Question: Summarize what this figure shows in one sentence.
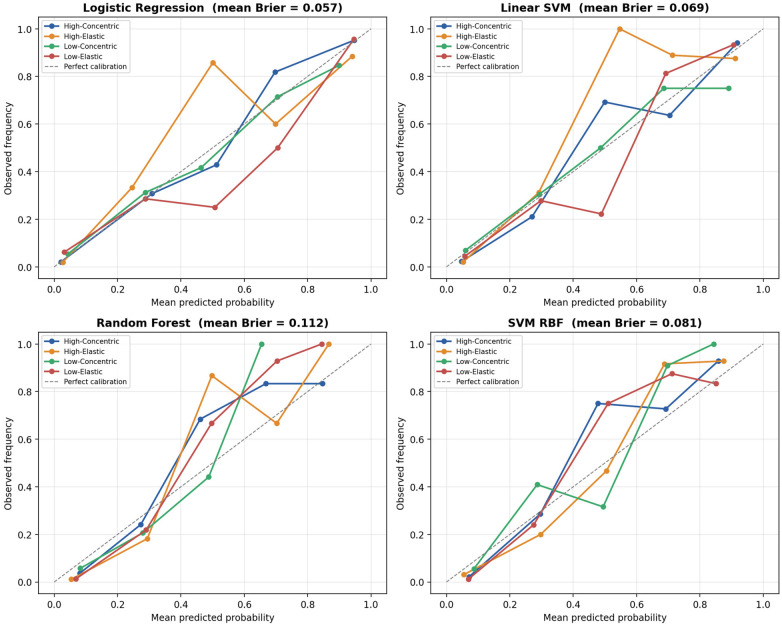
Answer: Multiclass calibration plots for the four algorithms. Logistic Regression achieved the best probability calibration (mean Brier Score = 0.057 across the four categories), indicating that its predicted probabilities were most consistent with observed frequencies.